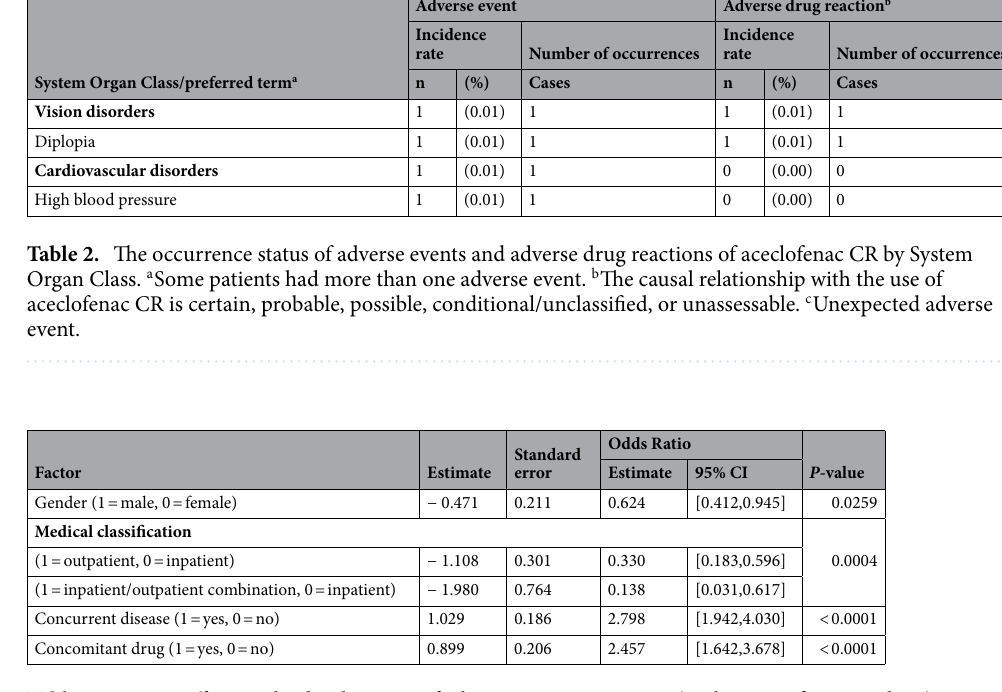
Table 3. Factors affecting the development of adverse event occurrence (multivariate factor analysis). 95% CI = 95% confidence interval. Multiple logistic regression analysis.